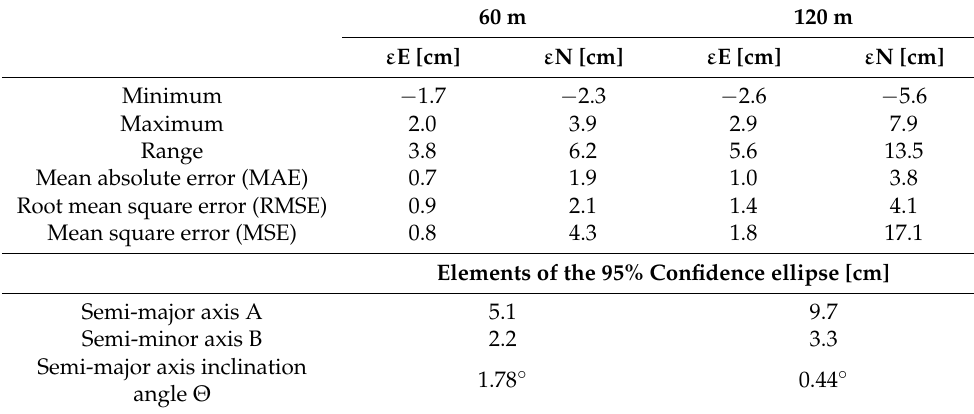
Root mean square error (RMSE)